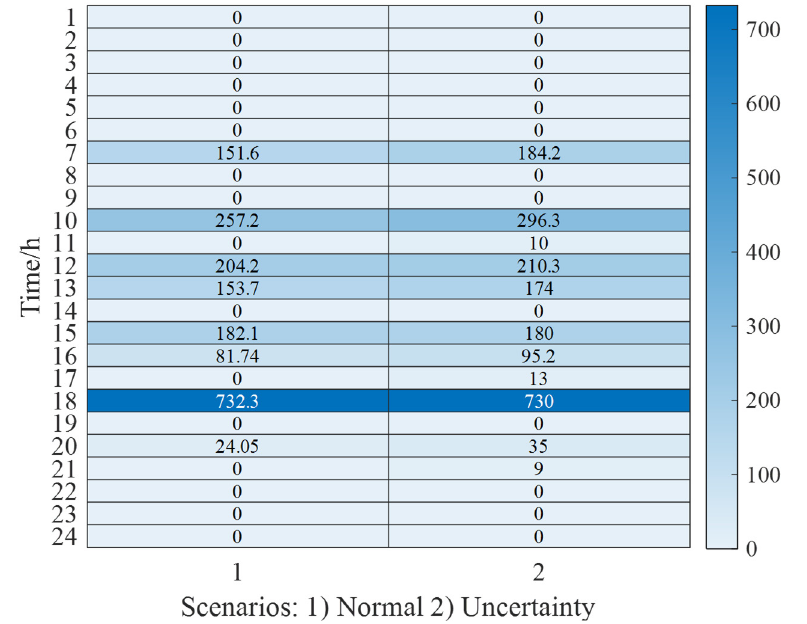
Figure 13. The output power of the tidal turbine for both scenarios.